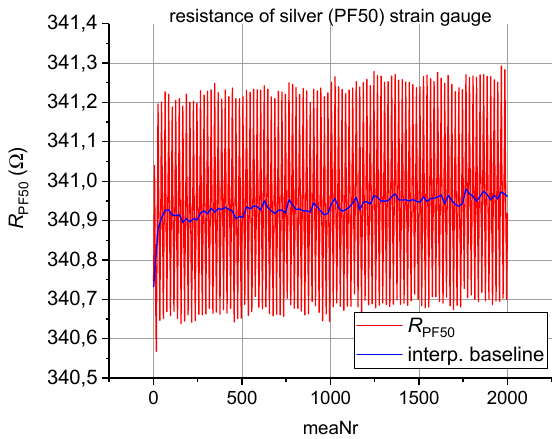
Figure 2. Silver ink based strain gauge measurement over 100 cycles, done at a constant temperature of 25 °C and 25% RH in a Weiss Technik WKL 100 climate chamber. No significant set-in effect is observed after the first 5–10 cycles, represented by the first 100–200 data points.